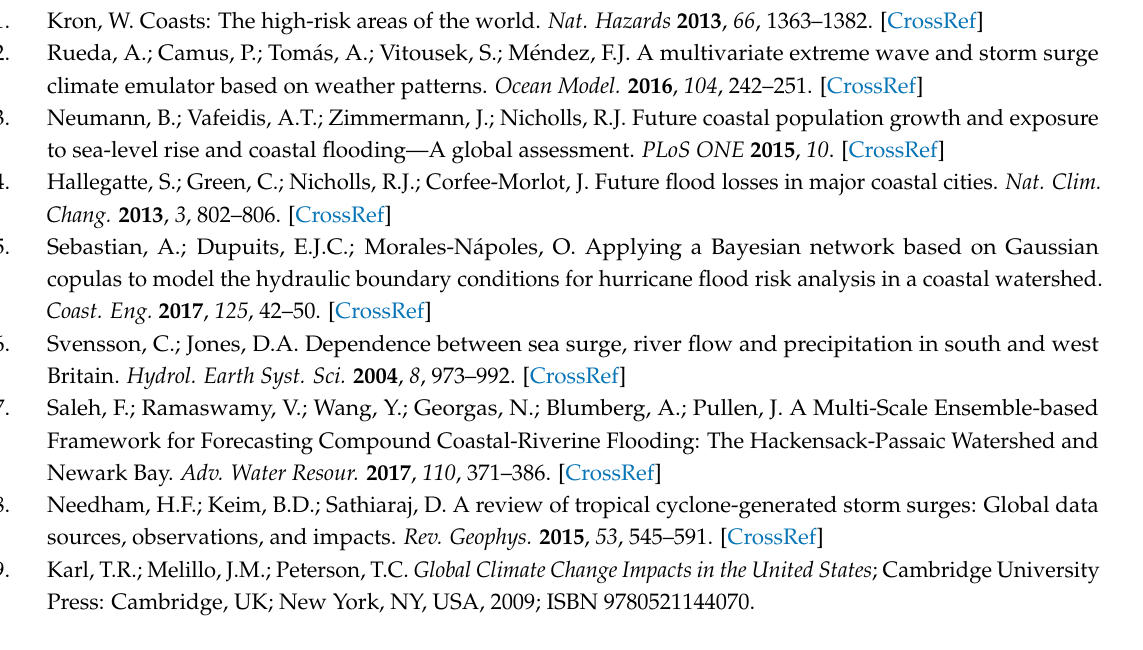
Section S1: Data Collection, Section S2: Marginal Distribution Fit, Section S3: Autocorrelation function, Section S4: 1-D Hydraulic Model Performance, Section S5: Bayesian Network Construction and Validation. Figure S1: Available records of mean daily discharge for the stations of interests. The most important change in the mean is shown in red. Table S1/S2: GEV distribution parameters for the discharge/storm surge distributions. Figure S2: Autocorrelation function (ACF) at the stations of interests. Figures S3 and S4: Performance of the simplified hydraulic model developed for this study. Table S3: Semi-correlation and Cram é r-von-Mises statistic for all variables used in the BN except for station QG, QS and QBB. Figure S5: Comparison of the maximum water levels observed for Tropical Storm Allison and Frances with the results from the 1-D hydraulic model. Figure S6: Selected examples of